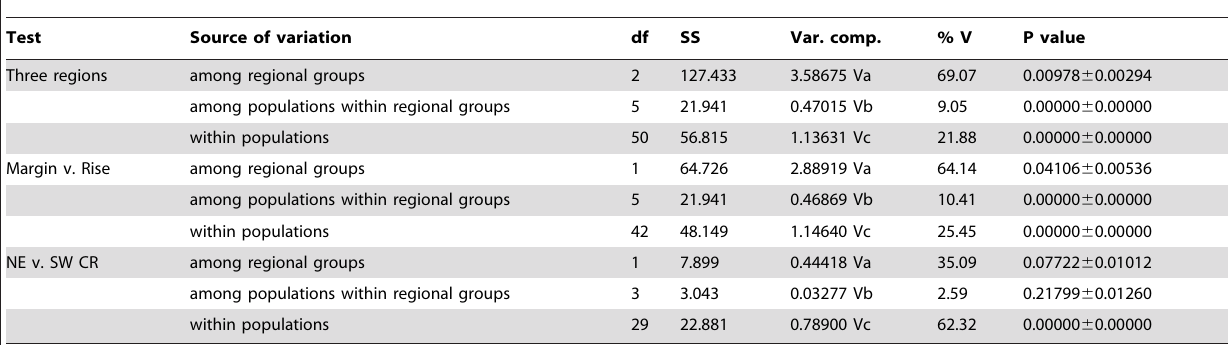
Table 9. COI AMOVA results for Hyalinoecia longibranchiata .